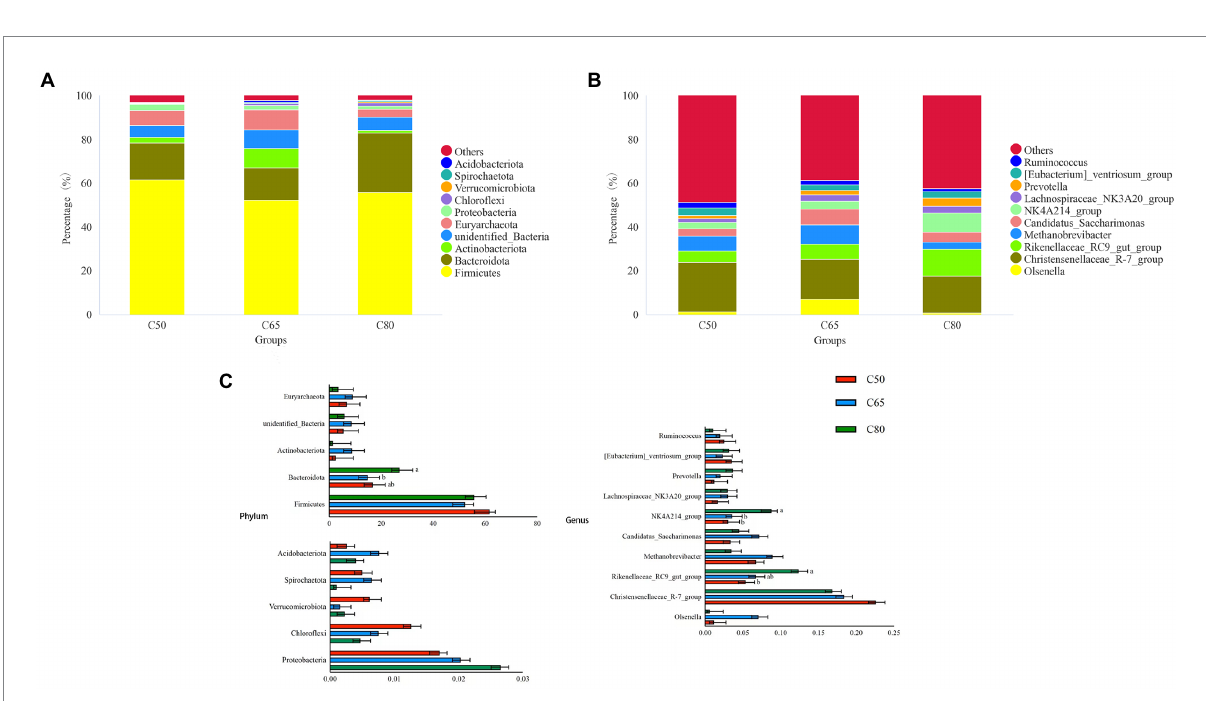
FIGURE 2 Bacterial composition of rumen samples from yaks with different dietary concentrate to forage ratio. Bacterial composition at the phylum (A) and genus (B) levels; (C) significantly different bacterial phylum and genus between groups, where different letters indicate significant differences between groups.